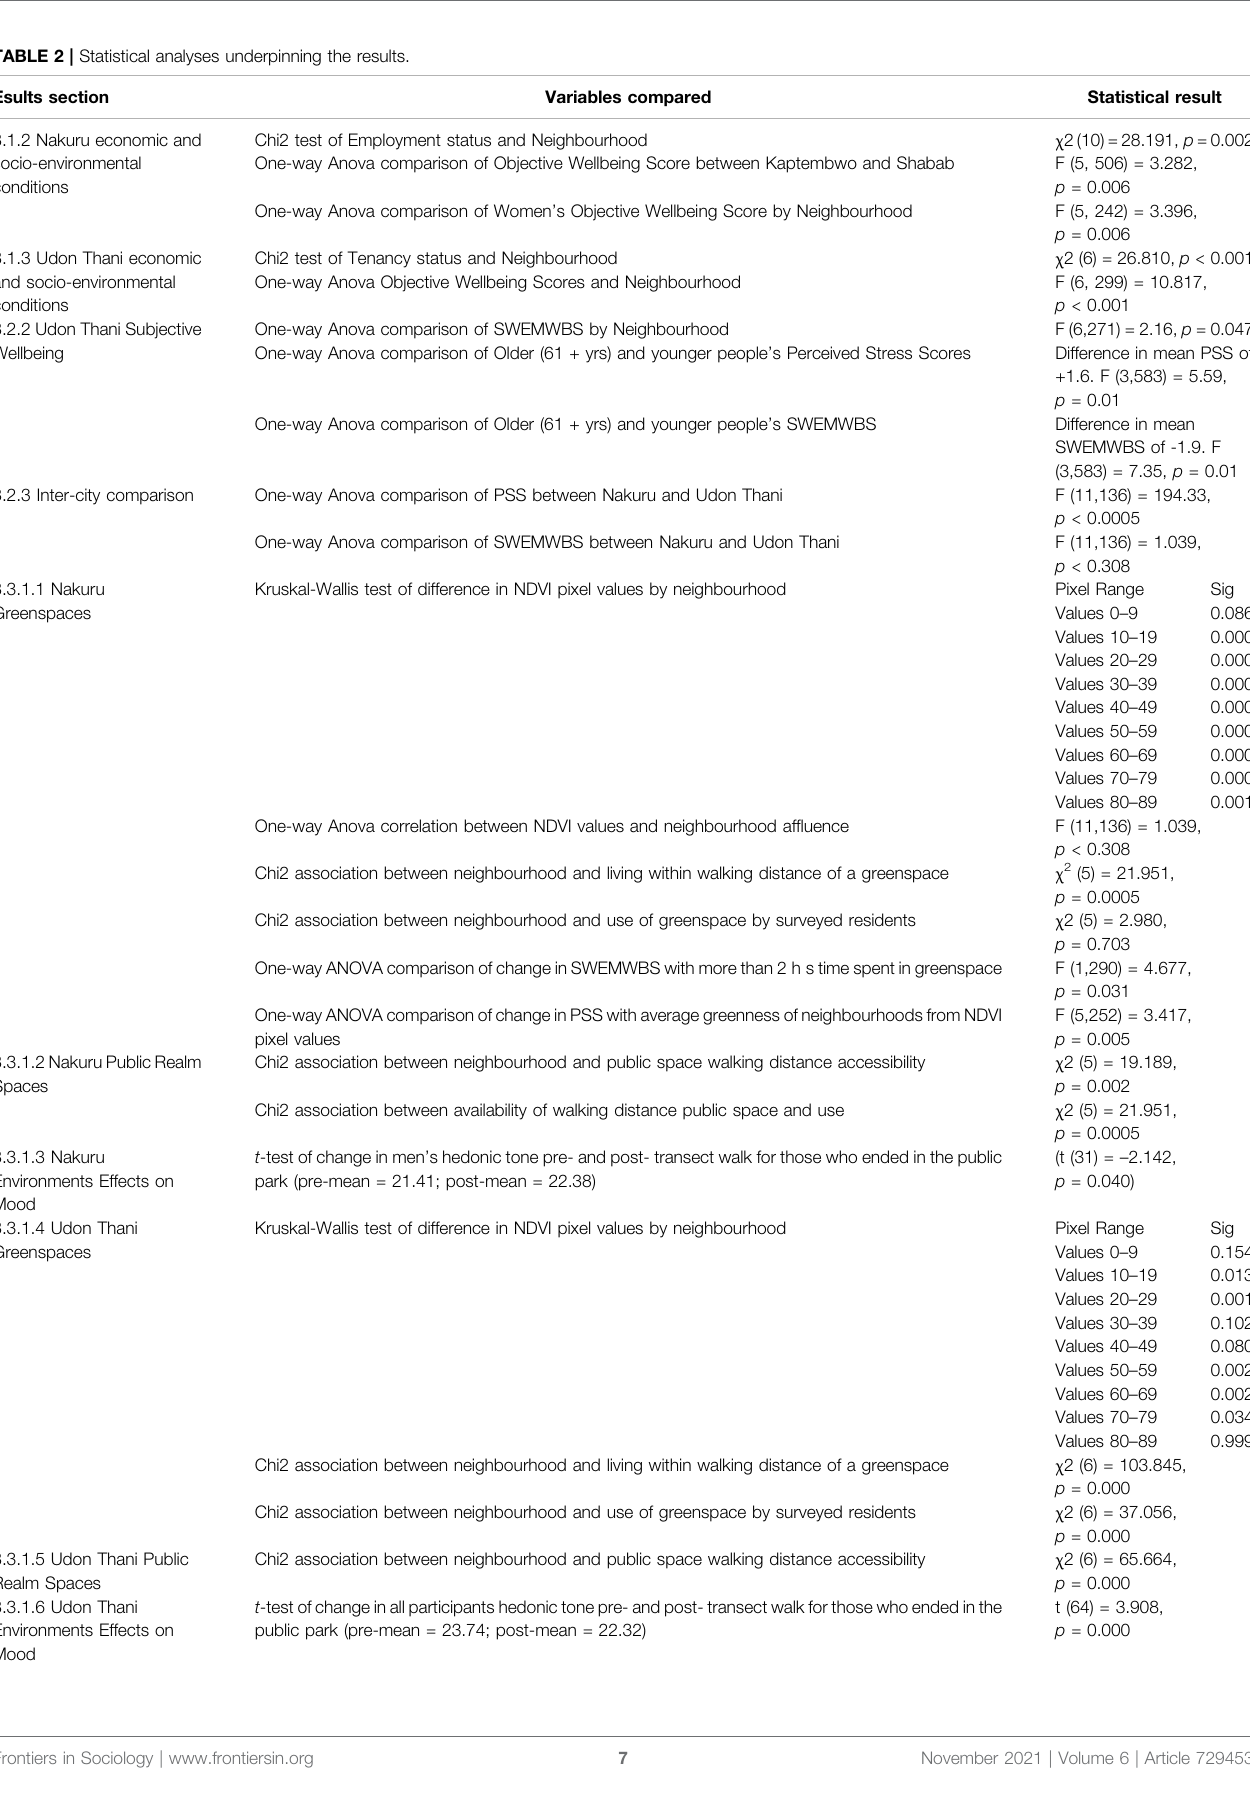
TABLE 2 | Statistical analyses underpinning the